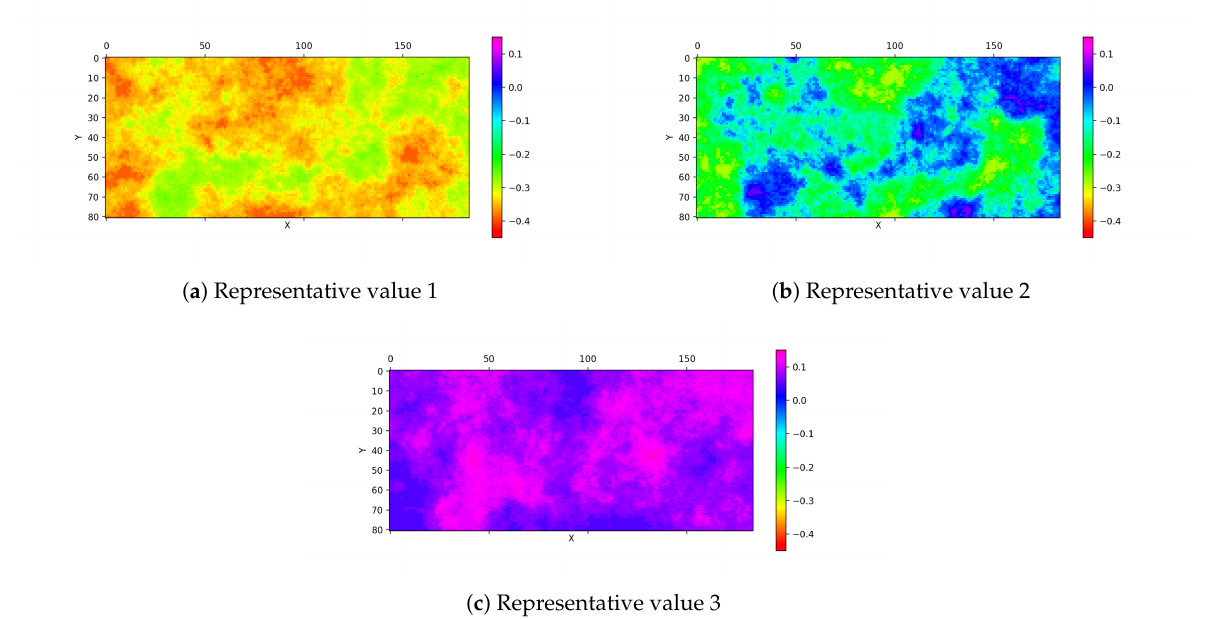
Figure 2. The random error field produced by SGS and scaled according to Equation (5) for three representative